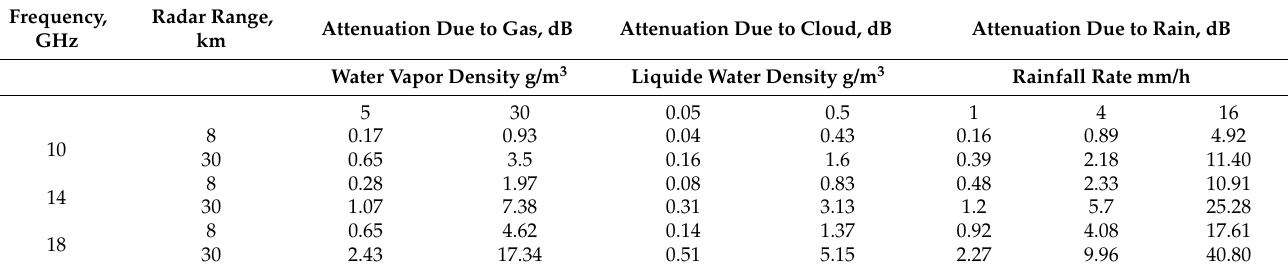
Table 2. Attenuation of the radar signal in the X-Ku bands due to gas, cloud, and rain.